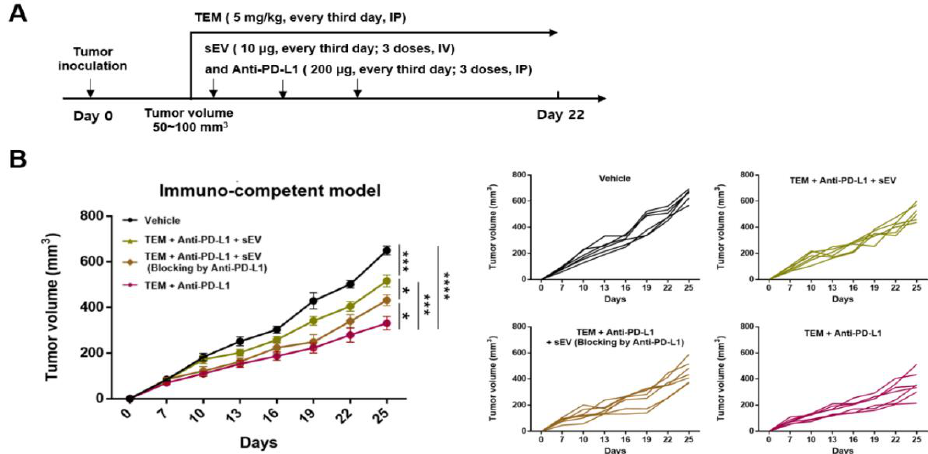
Figure 6. The addition of exogenous sEV PD-L1 reverses the anti-cancer effect induced by TEM and anti-PD-L1 antibodies. ( A ) The design of the tumor rescue experiment with exogenous sEV PD-L1 injections in syngeneic 4T1-bearing models. ( B ) The growth curves of 4T1 tumors in immunocompetent mice injected with the indicated treatment ( n = 6 – 7). The data are presented as means ± standard error of the mean (SEM). * p < 0.05, *** p < 0.001, and **** p < 0.0001, respectively; ns, not significant.